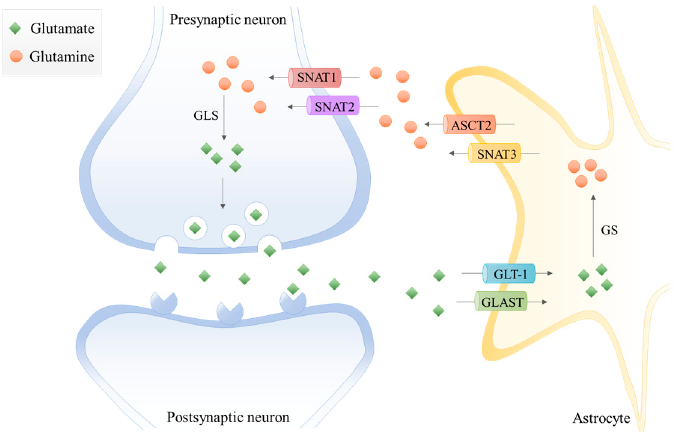
Figure 1. The glutamate-glutamine cycle in a glutamatergic synapse. The released neurotransmitter glutamate is imported by astrocytes through the glutamate transporter 1 (GLT-1) and glutamate aspartate transporter (GLAST). Then, glutamine synthetase (GS) catalyzes the glutamate amidation reaction, generating glutamine using free ammonia. The glutamine is then released from astrocytes via system A amino acid transporter 3 (SNAT3) and alanine/serine/cysteine-preferring transporter (ASCT2) and imported by presynaptic neurons through system A amino acid transporters 1 and 2 (SNAT1 and SNAT2). The glutamine is hydrolyzed to glutamate by glutaminase (GLS), which is packed into synaptic vesicles being sent to the synaptic cleft during neurotransmission. Finally, glutamate is imported again by the astrocytes.